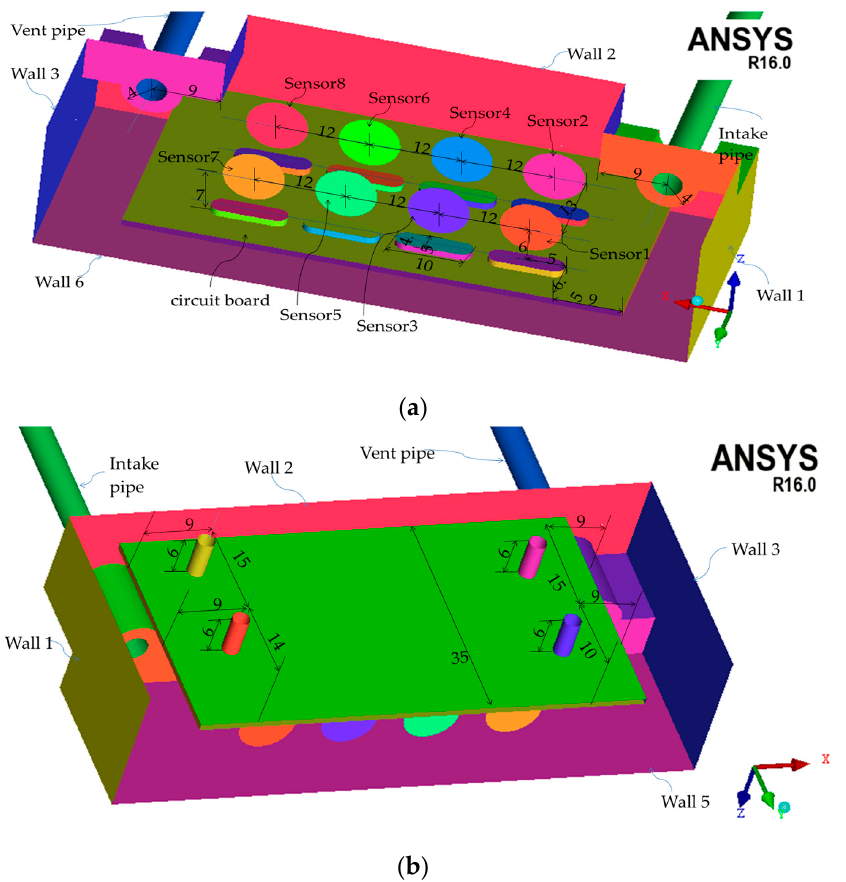
Figure 9. The structure in sensor box’s cavity. ( a ) Partial view 1; ( b ) Partial view 2.